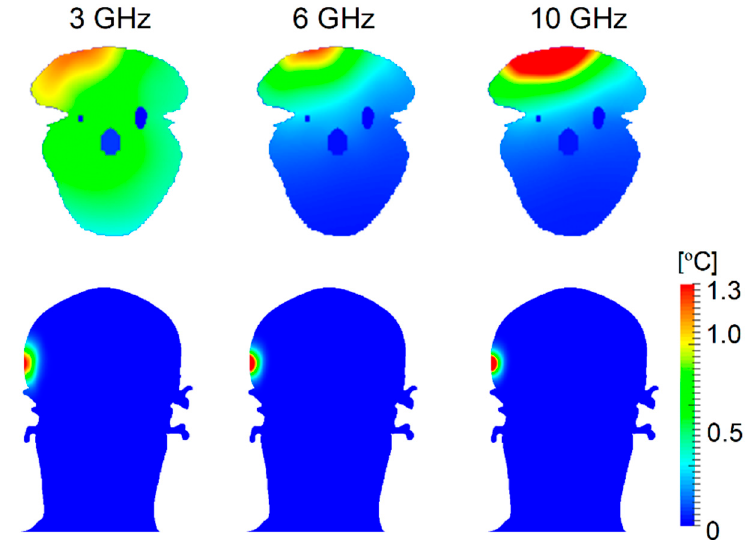
Figure 4. Distribution of temperature elevation in the rat and TARO models at 3, 6, and 10 GHz. The distance between the skin surface and the dipole antenna was set to 5 mm. The output power of the antenna was adjusted so that the peak SAR averaged over 10-g tissue was equal to 10 W/kg.